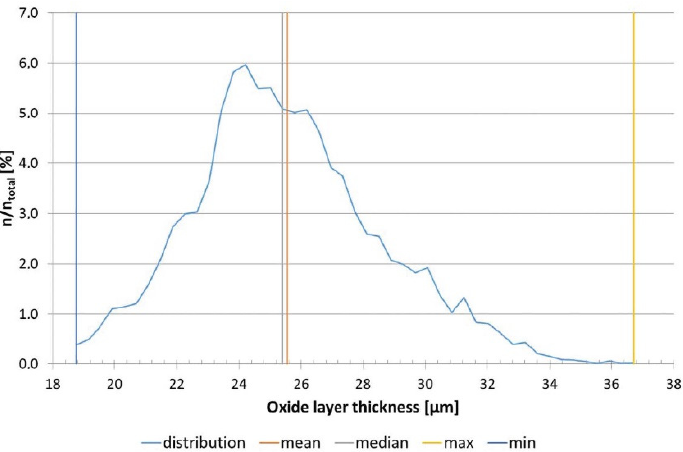
Figure 7. Oxide layer thickness distribution curve and t mean , t median , t max, and t min of a single corrosion test with 10CrMo9-10 covered with a KCl deposit treated at 550 °C in a steam atmosphere. (n total is 10,000).